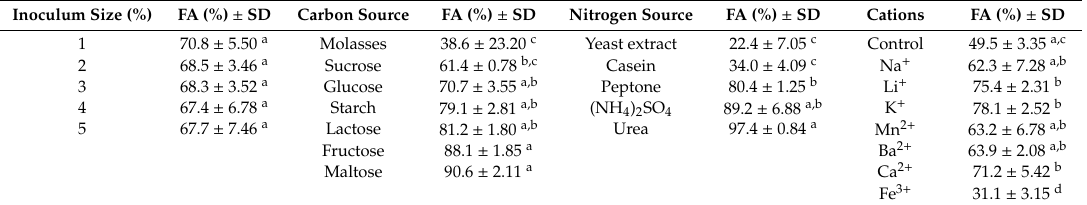
Table 1. E ff ect of inoculum size, carbon sources, nitrogen sources and cations on flocculation. Inoculum Size (%) FA (%) ± SD Carbon Source FA (%) ± SD Nitrogen Source FA (%) ± SD